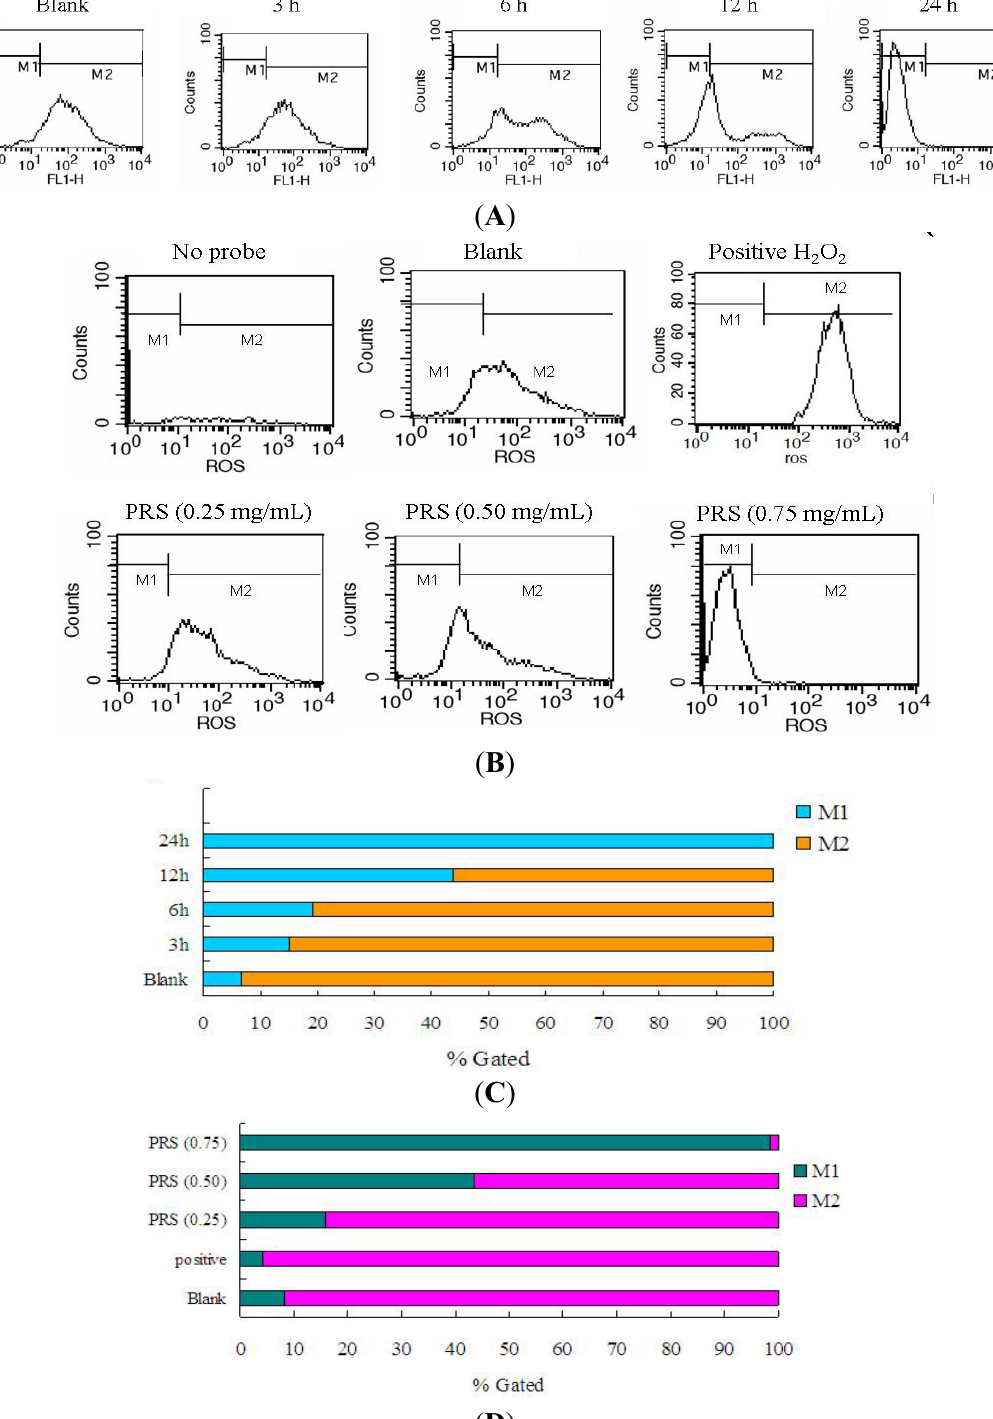
Figure 8. Reduction of PRS on ROS generation in A549 cells. Cells were induced in absence or presence of PRS (0.5 mg/mL) for 3, 6, 12 or 24 h ( A and C ) and then ROS production was assessed by flow cytometry with a fluorescence probe 2',7'-dichlorodihydrofluorescein diacetate (DCFH-DA) staining. Furthermore, A549 cells were treated with PRS (0.25, 0.5, 0.75 mg/mL) for 24 h ( B and D ). In this study, 100 μ M H control. The significant increase in ROS was calculated the counts in the M2